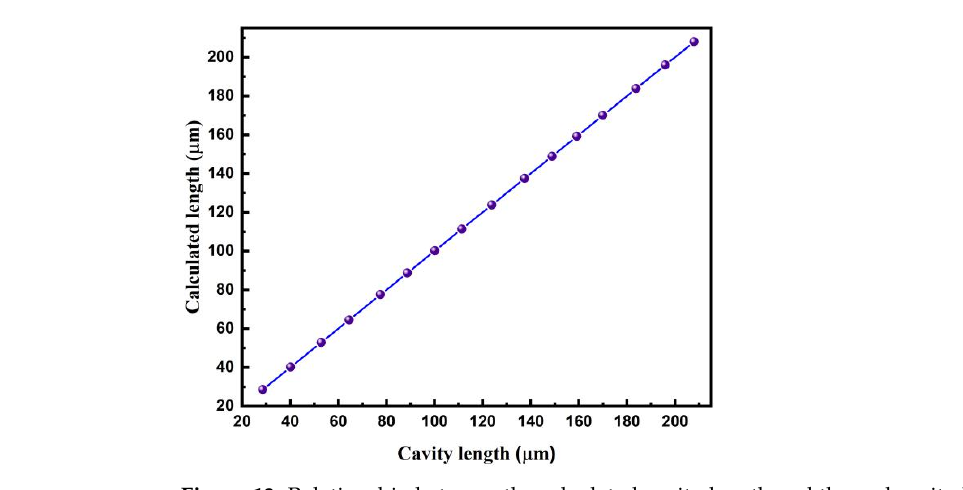
Figure 13. Relationship between the calculated cavity length and the real cavity length for fiber-optic F–P sensors through the proposed dual SLD cross-correlation demodulation method.